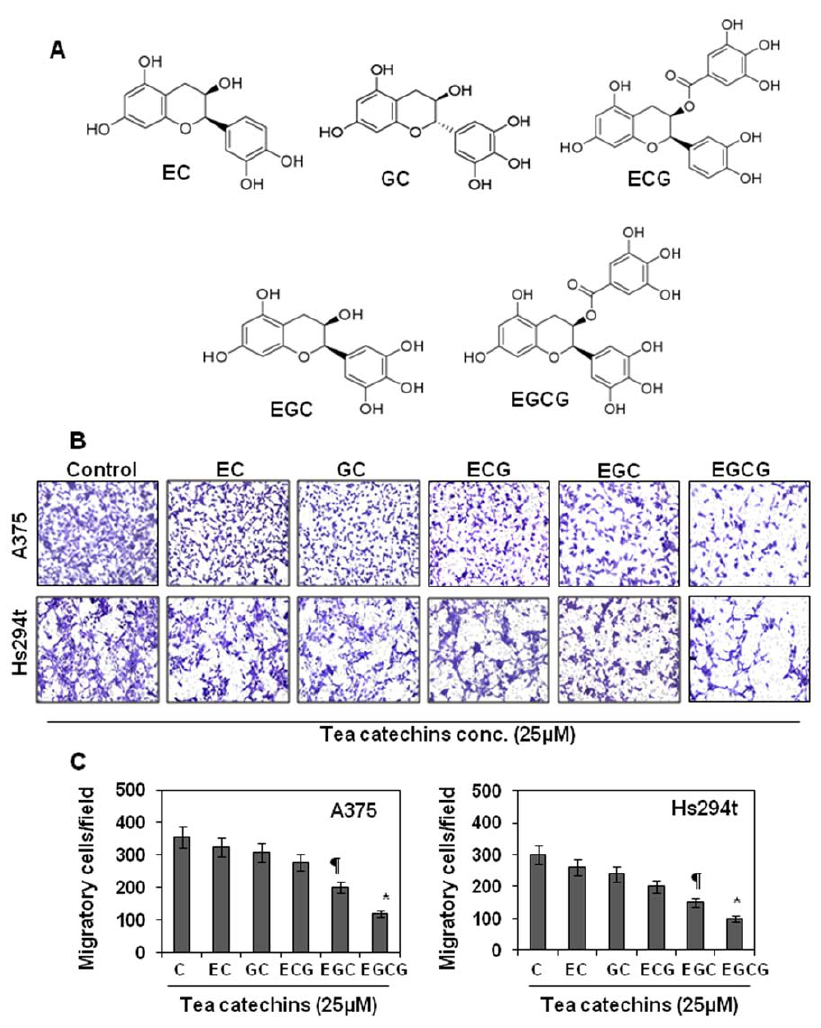
Figure 1. Comparative effects of green tea catechins on the cell invasion capacity of melanoma cells. ( A ) Chemical structures of major green tea catechins. EC, (-)-epicatechin; GC, (-)-gallocatechin; ECG, (-)-epicatechin-3-gallate; EGC, (-)-epigallocatechin, and EGCG, (-)-epigallocatechin- 3-gallate. ( B ) Effect of equimolar concentration (25 m M) of various green tea catechins on the migration of human melanoma cells (A375 and Hs294t) after treatment for 24 h. ( C ) The migrating cells were counted and the results expressed as the mean number of migratory cells 6 SD/microscopic field. Data collected from three independent experiments. Significant inhibition by EGC and EGCG versus non-tea catechins-treated controls, " P , 0.01; * P , 0.001.